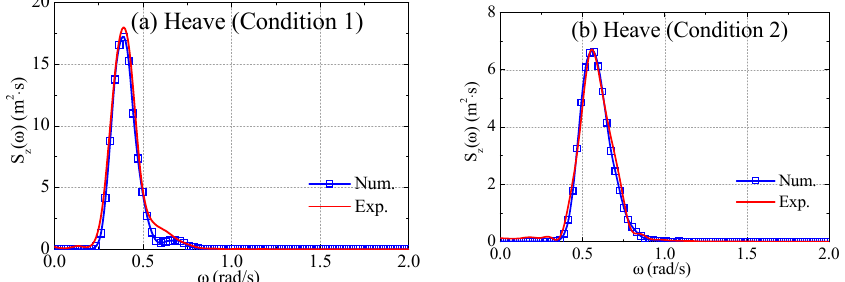
Figure 7. Comparison of heave spectra.